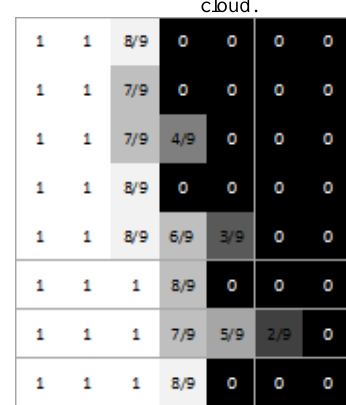
Figure 1. Fuzzy edges in a) raw range image b) point cloud.